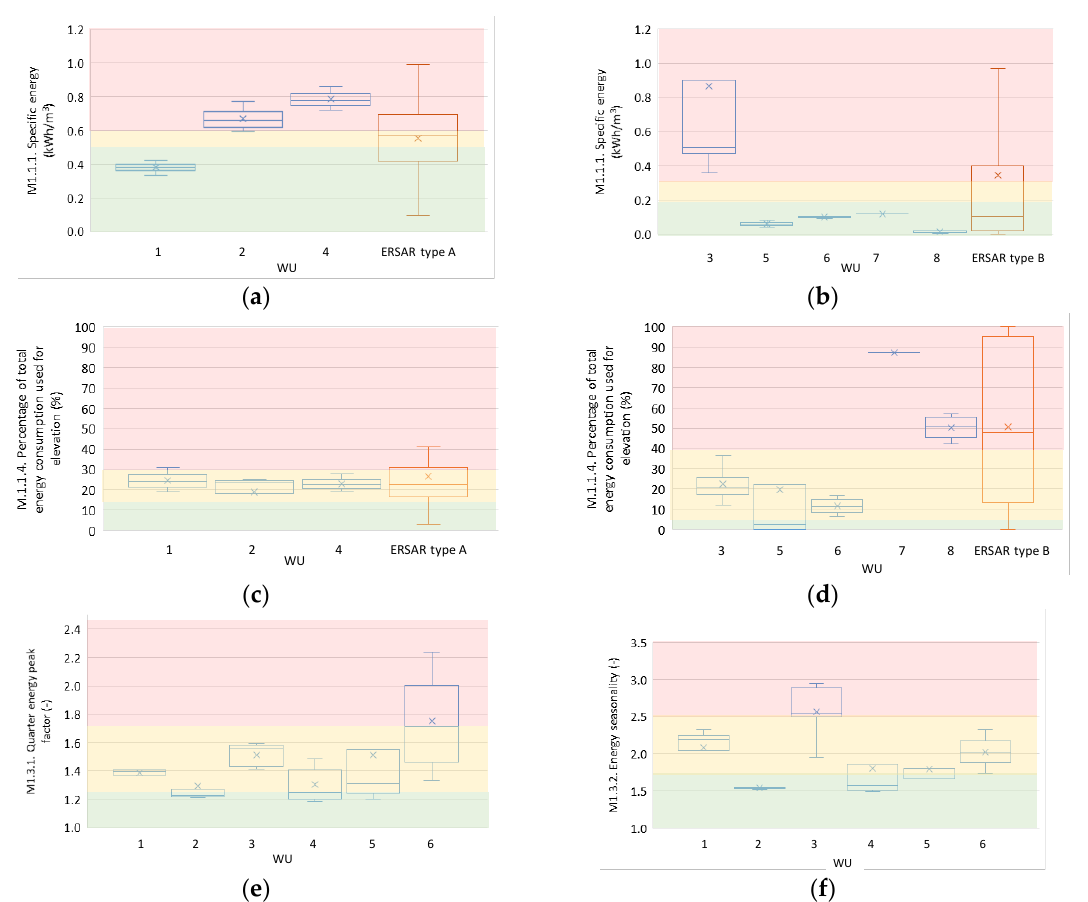
Figure 5. Results for the selected metrics of Objective 1: ( a ) M1.1.1 Type A WU; ( b ) M1.1.1 Type B WU; ( c ) M1.1.4 Type A WU; ( d ) M1.1.4 Type B WU; ( e ) M1.3.1; and ( f ) M1.3.2.